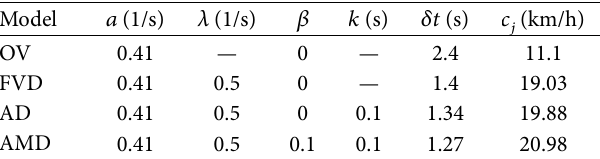
Figure 4: Motion of eleven vehicles starting up from a red traffic signal. (a) The OV model, (b) The FVD model, (c) The AD model, and (d) The AMD model. Table 2: Delay times of vehicle motions from a traffic signal and kinematic wave speed at jam density in different models.